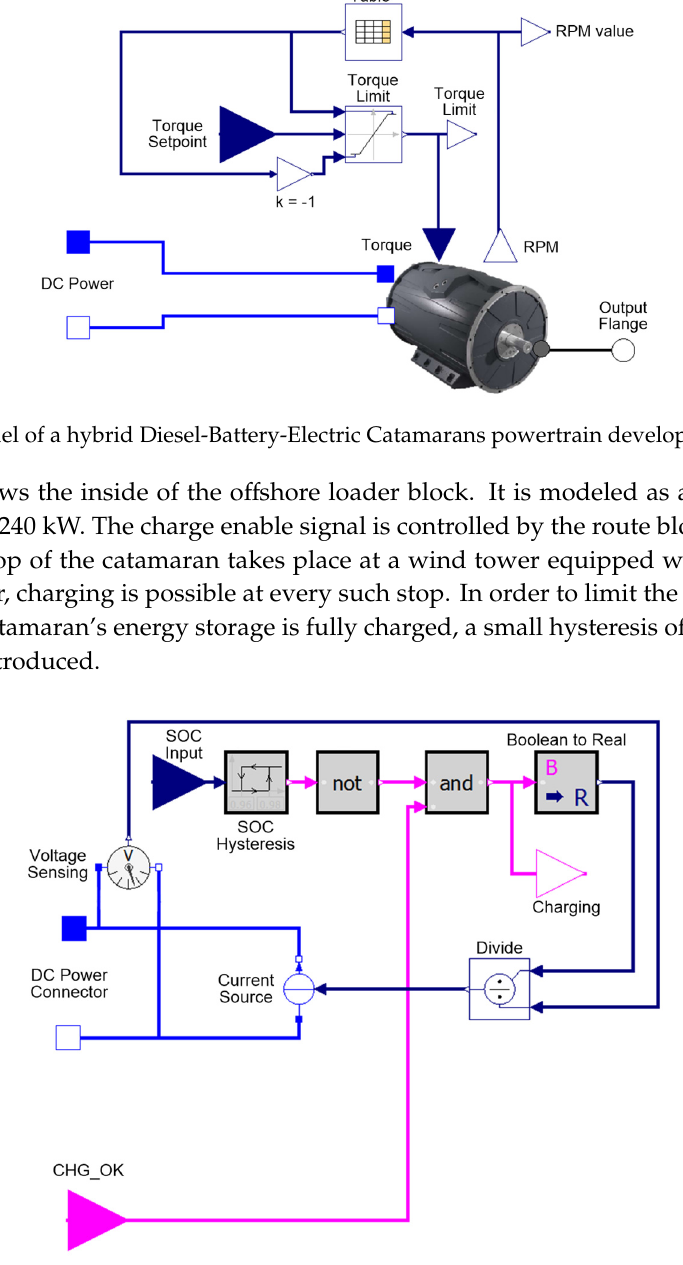
Figure 12. Onboard charger block details.